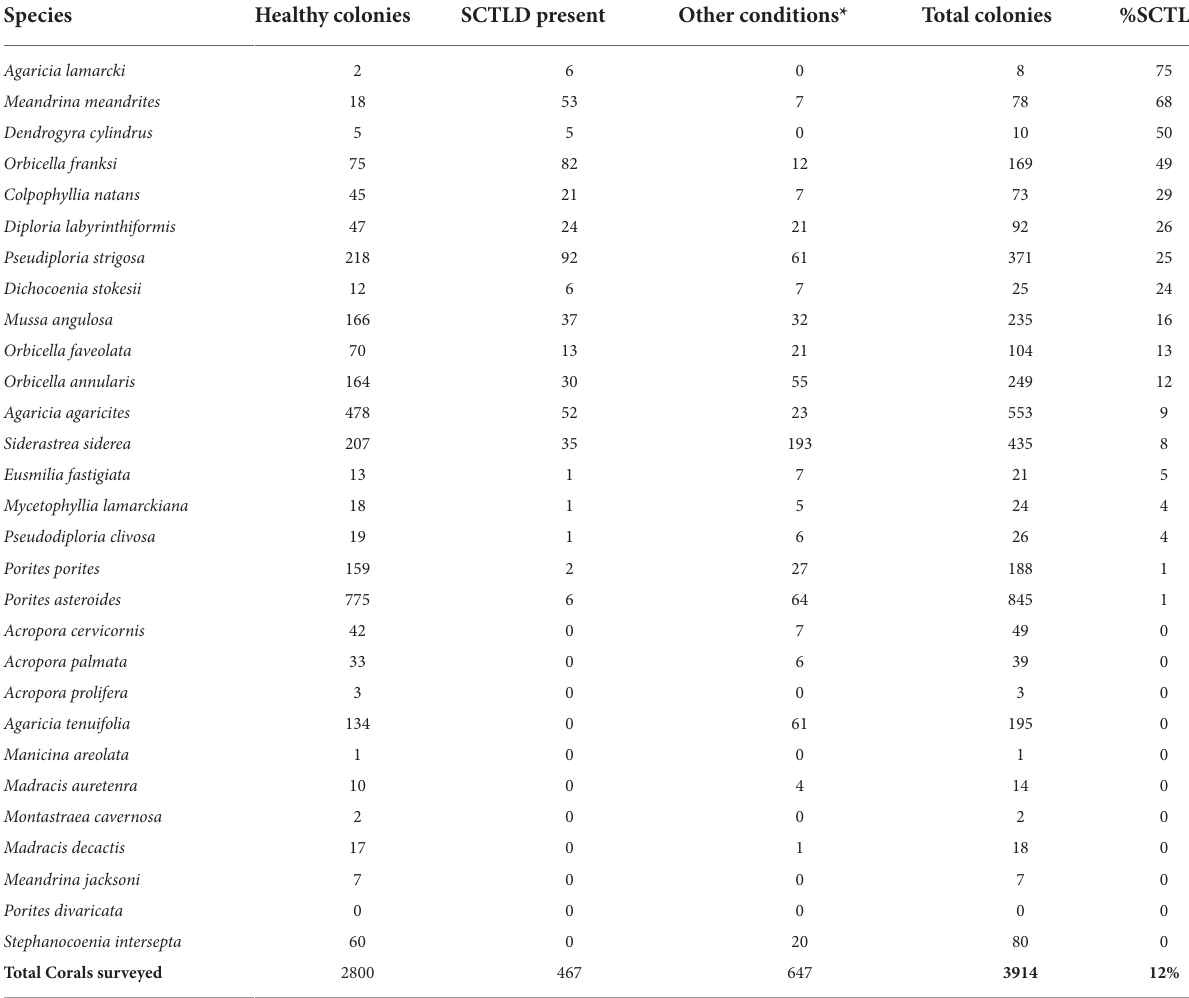
TABLE 1 List of coral species surveyed in Belize highlighting species health and showing prevalence of SCTLD within colonies. Species Healthy